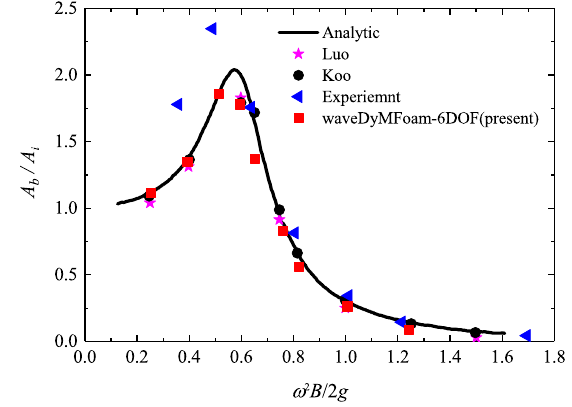
Figure 4. Schematic diagram of the wave interaction with a heave-only box.